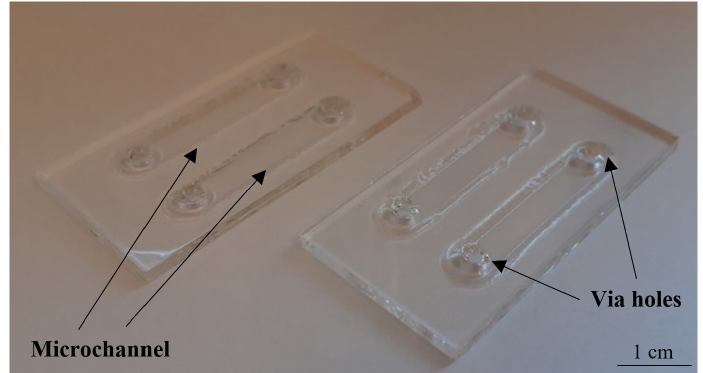
Figure 5. All-glass LOCs at a glance.